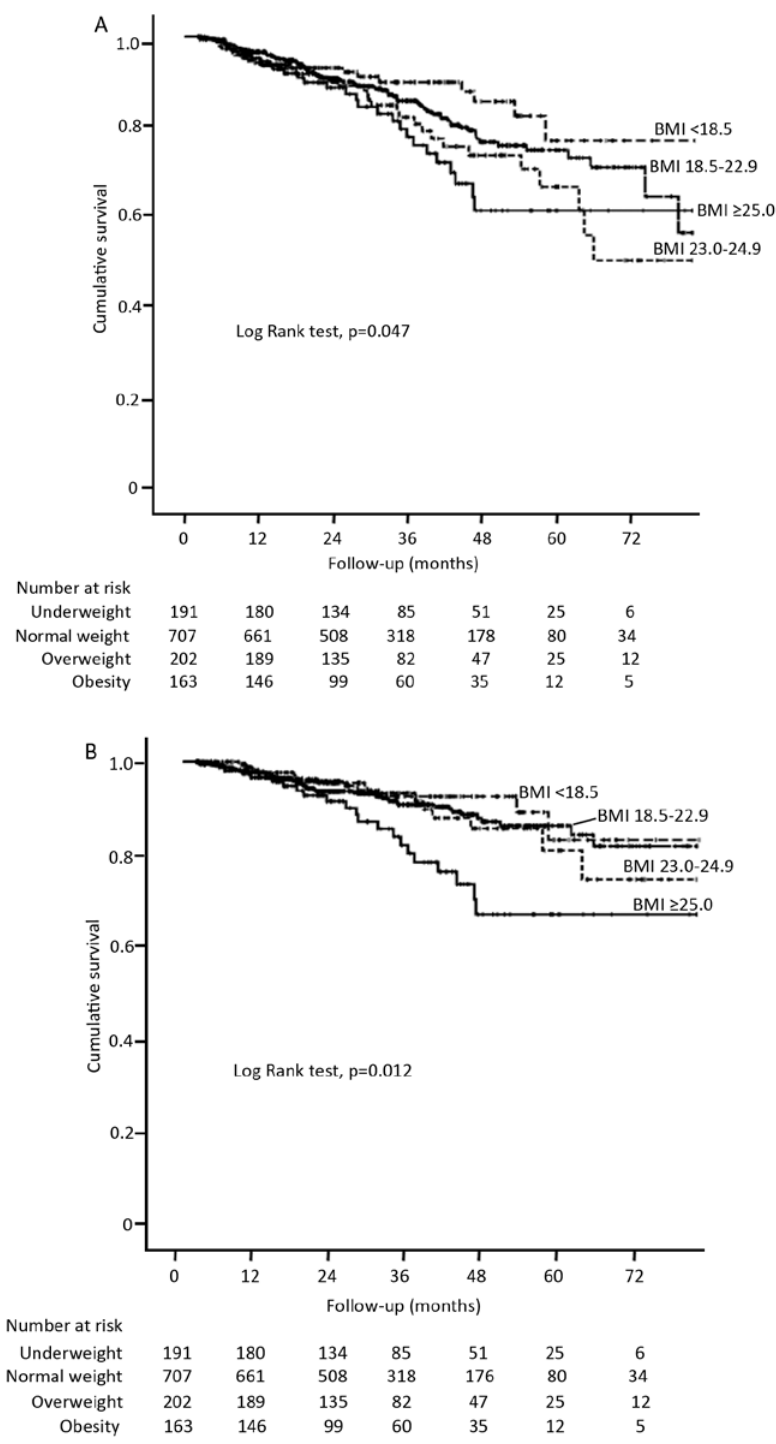
Figure 1. Kaplan Meier curves for all-cause mortality ( A ) and cardiovascular mortality ( B ) in incident continuous ambulatory peritoneal dialysis (CAPD) patients by BMI categories.